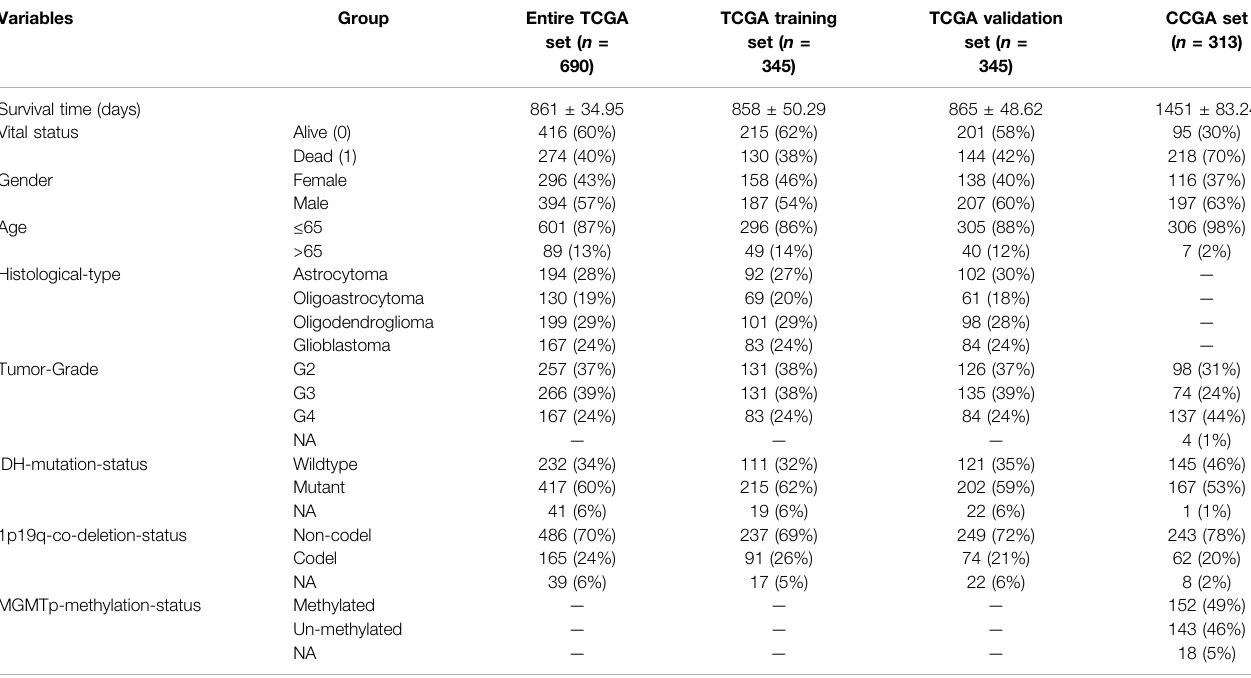
TABLE 1 | Clinical information of the entire TCGA set, TCGA training set, TCGA validation set and CGGA set. NA, Not available; TCGA, The Cancer Genome Atlas; CGGA, Chinese Glioma Genome Atlas.